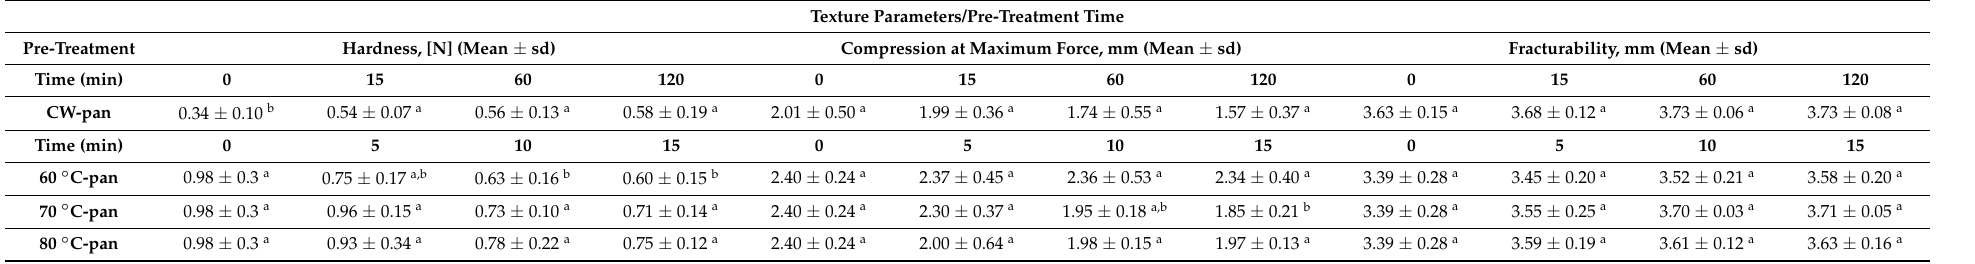
Table 5. Texture attributes of French fries pre-treated with